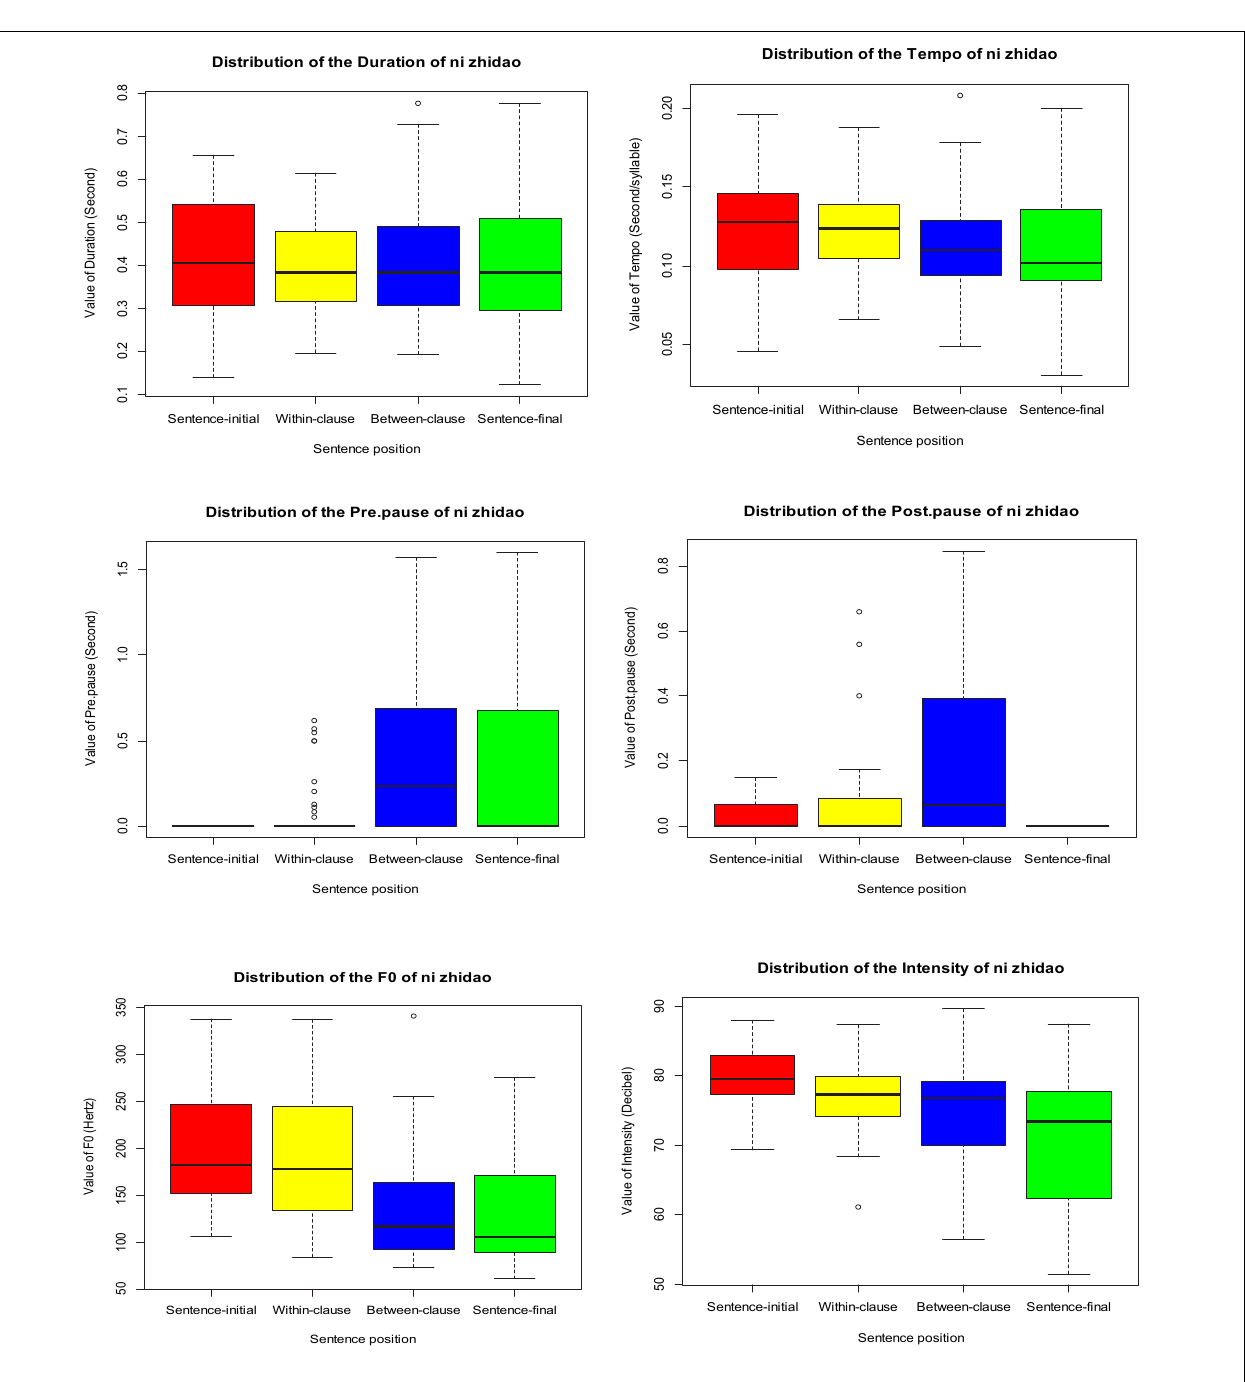
FIGURE 5 | Prosodic features of ni zhidao in four sentence